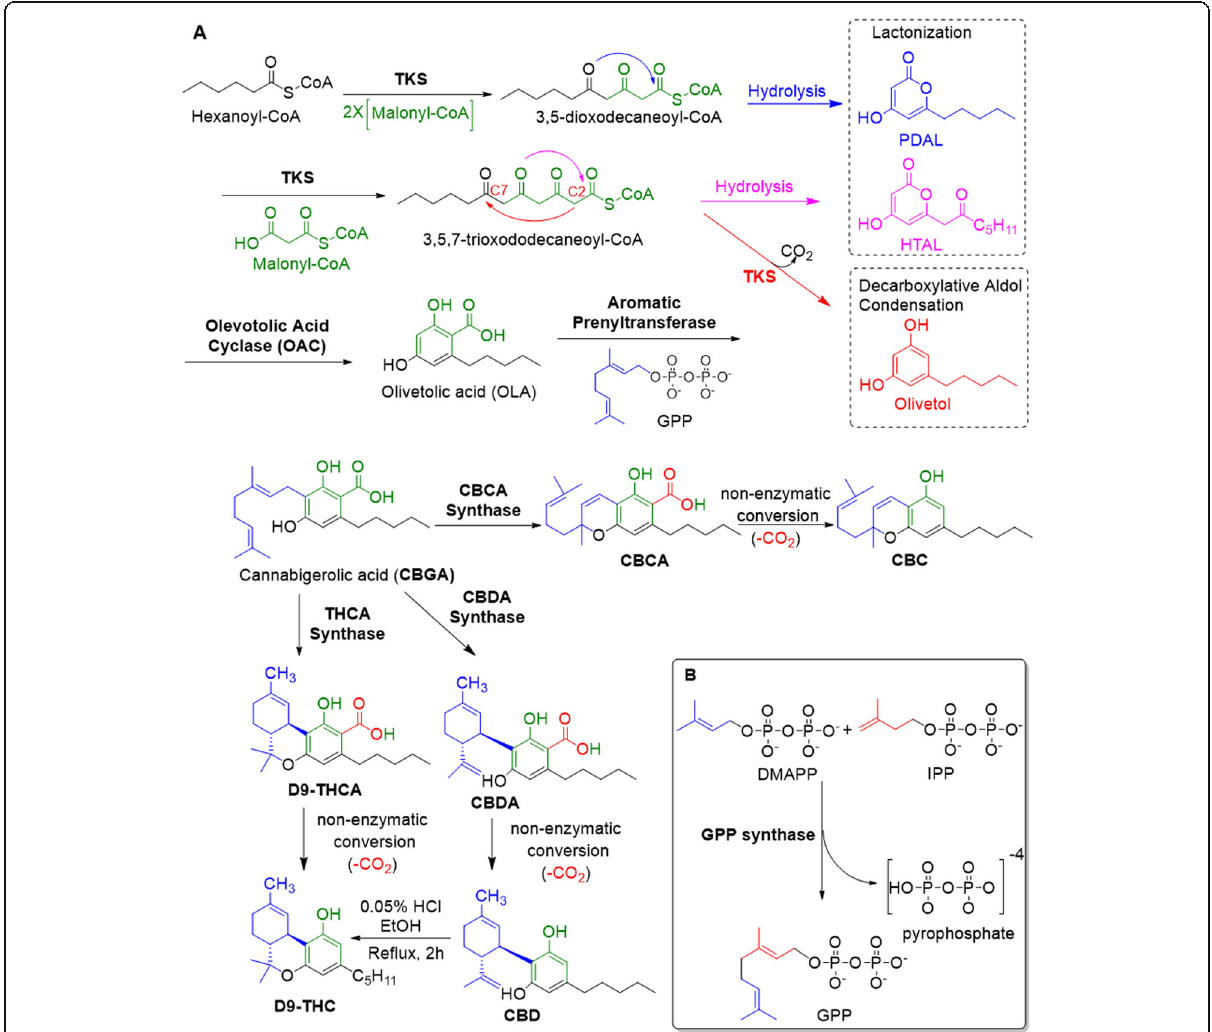
Fig. 2 Biosynthesis of cannabinoids. a Proposed cannabinoid biosynthetic pathway for Δ 9 -tetrahydrocannabinol ( Δ 9 -THC), cannabidiol (CBD), and cannabichromene (CBC) including by-product formation (pentyl diacetic lactone (PDAL), hexanoyl triacetic acid lactone (HTAL), and olivetol shown in the dotted box) and highlighting the chemical conversion of CBD into THC, long thought to be the source of THC, but this conversion does not occur in vivo. b Synthesis of geranyl pyrophosphate (GPP) from dimethylallyl pyrophosphate (DMAPP) and isopentenyl pyrophosphate (IPP) catalyzed by geranyl pyrophosphate